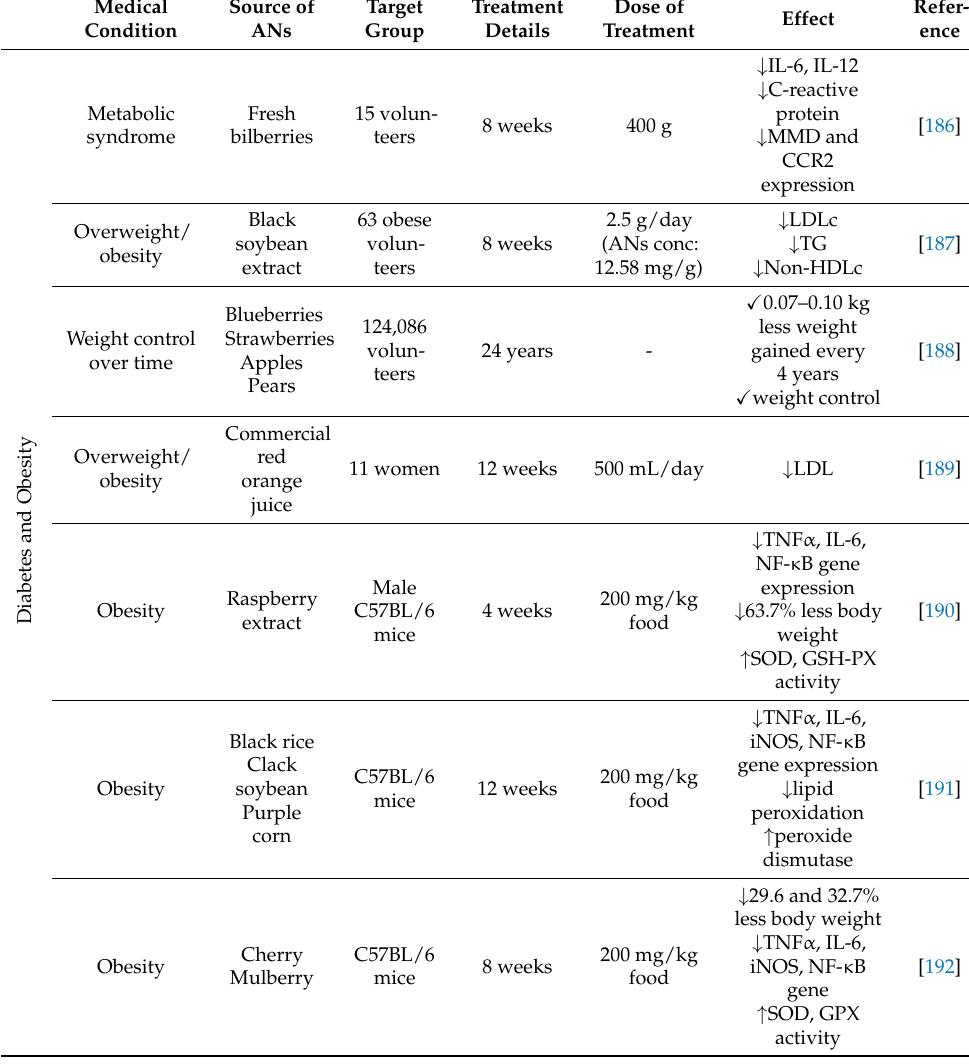
Table 2. In vivo studies of ANs and their health improvements in different pathologies such as diabetes, obesity, cancer, neurological, and cariological